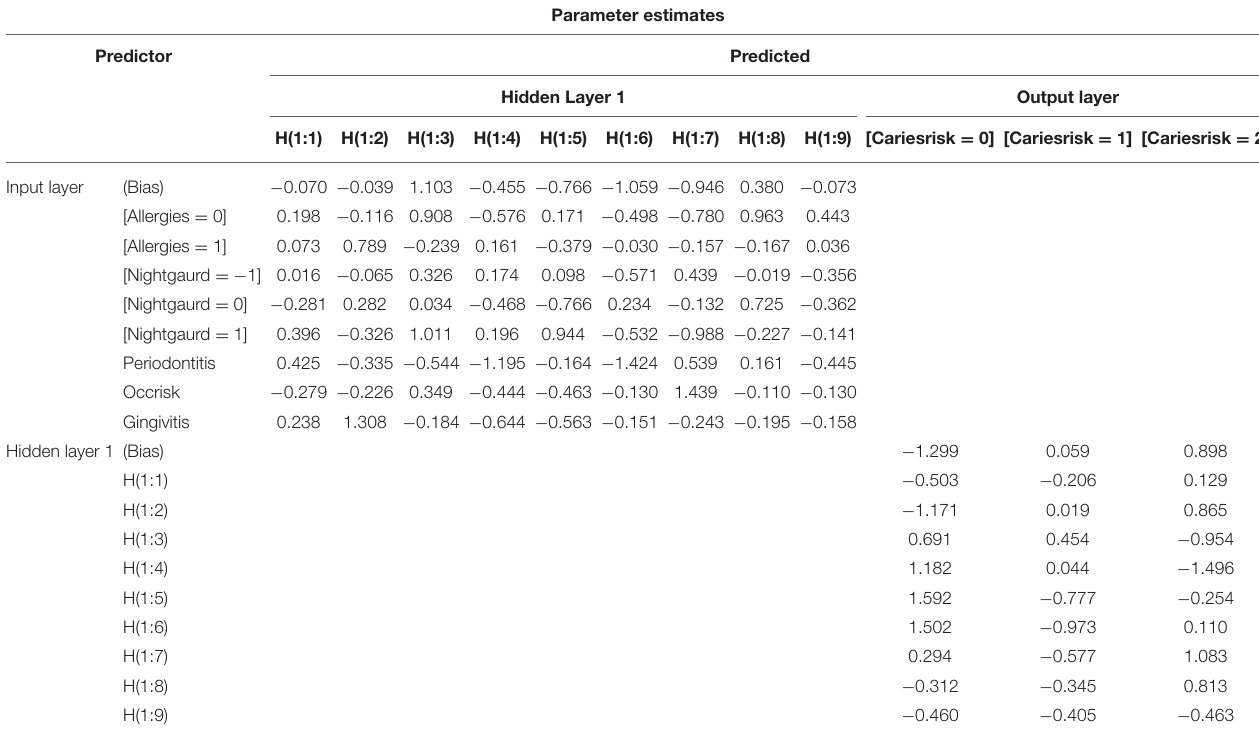
TABLE 4 | Weights associated with the ANN analysis to calculate caries risk as an outcome using its significant